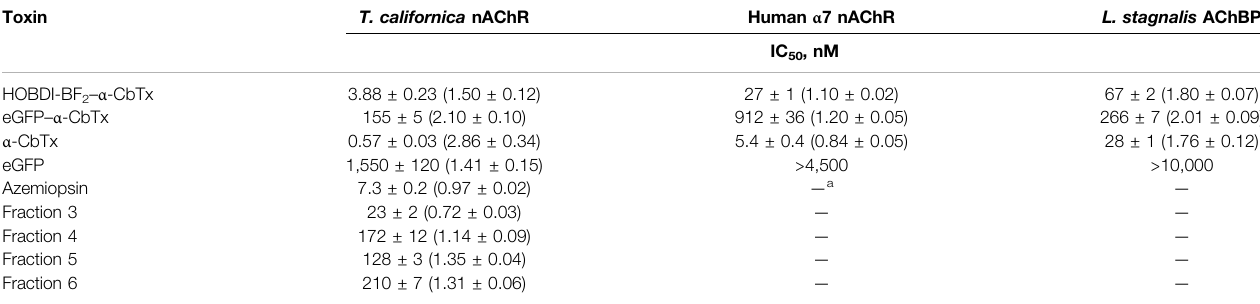
TABLE 2 | Af fi nity of the fl uorescent toxins tested in competition with 125 I- α -BgTx for binding to muscle-type nAChR from T. californica , human neuronal α 7 nAChR, and AChBP from L. stagnalis calculated from the respective inhibition curves in Figure 4 as the IC 50 values and Hill coef fi cients (n H ) using OriginPro 2015. Toxin T. californica nAChR Human α 7